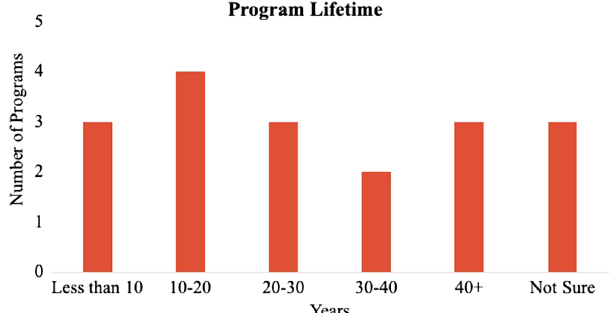
FIG. 8. The length of time in years that programs in our sample have been